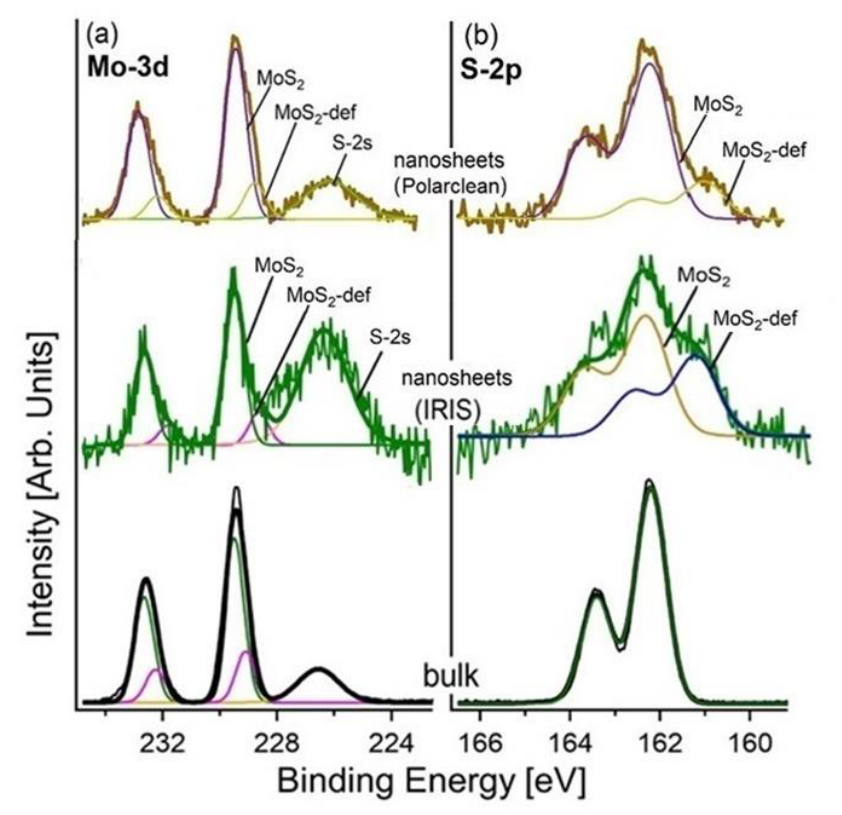
Figure 4. ( a ) The Mo-3d and ( b ) S-2p core levels of the bulk MoS 2 and MoS 2 nanosheets produced by LPE with Polarclean (taken from [70] with permission) and Iris. The component at a BE of 226.7 eV in the Mo-3d core level (in panel a) was related to the overlap of the S-2s core level. The photon energy was 1486.6 eV (Al K α ), and the spectra were normalised to the maximum.